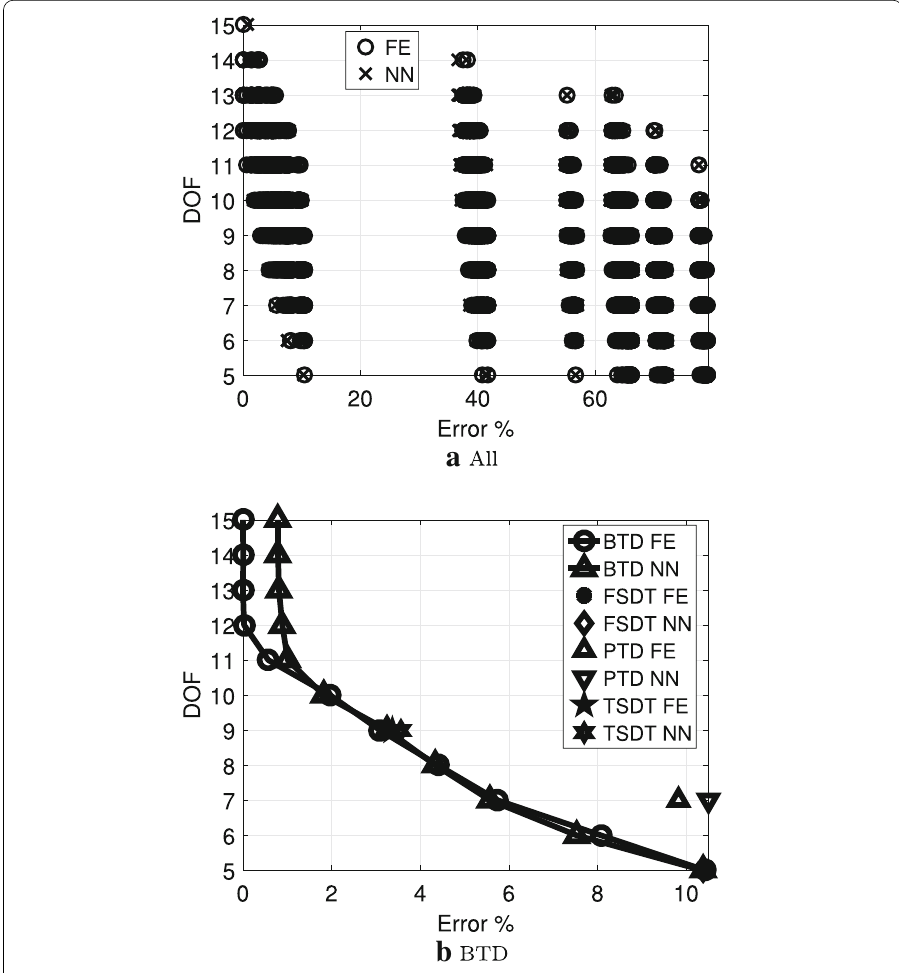
Fig. 15 FE and NN results for 0/90/0/90, a/h = 10, three layers with ten neurons